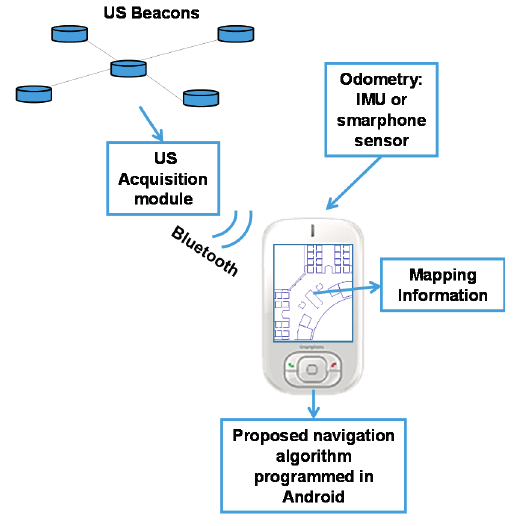
Figure 12. Proposed scheme for human